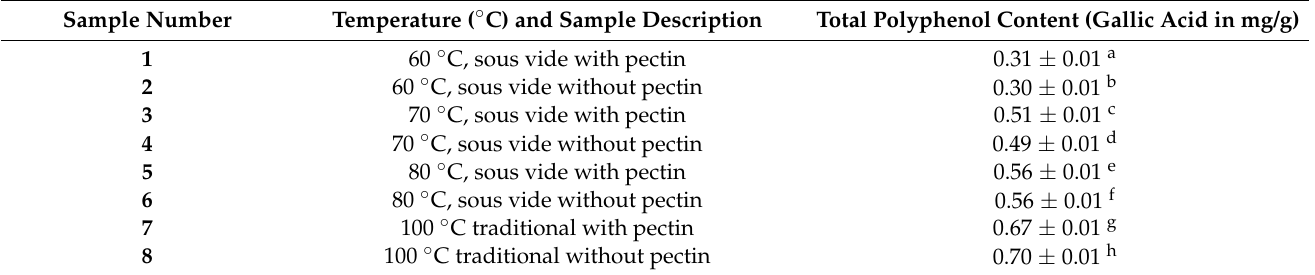
Table 3. Influence of cooking on the total polyphenol content in medlar jam prepared by the sous vide method and the classic cooking method,